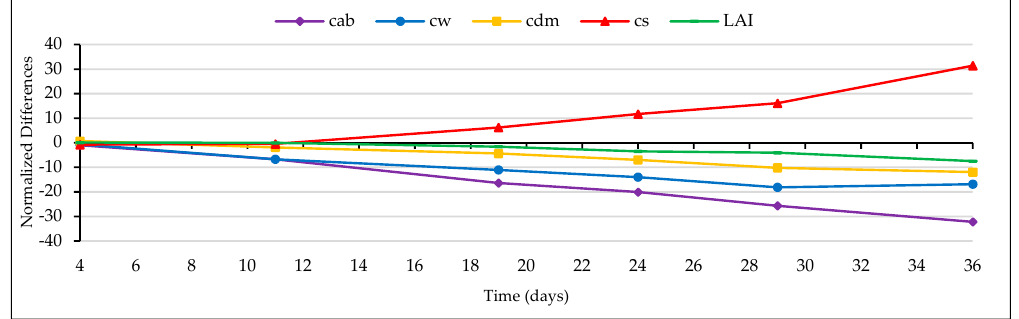
Figure 12. Normalized differences and relative changes of the parameters during the experiment.